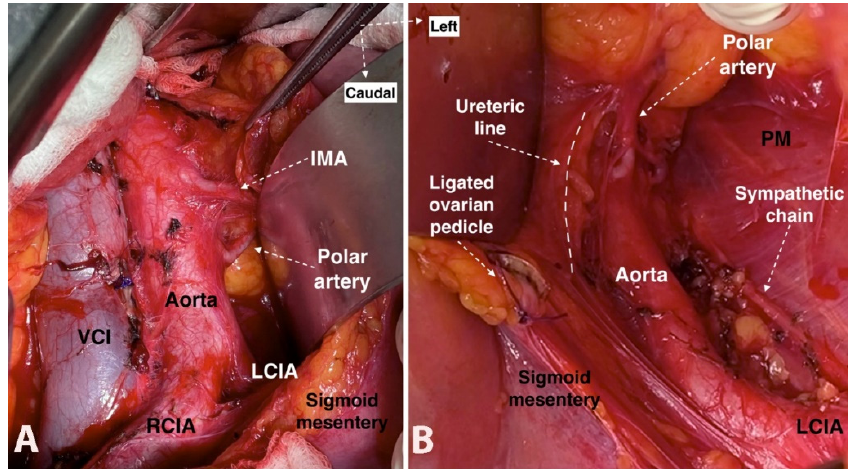
Figure 10. Additional left aortic lower polar renal artery arising from the lateral aspect of the abdominal aorta (embalmed cadaver). The artery originates from the abdominal aorta just below the origin of the inferior mesenteric artery. AA—abdominal aorta, IVC—inferior vena cava, RCIA—right common iliac artery, LCIA—left common iliac artery, LCIV—left common iliac vein, LRV—left renal vein, LRA—left renal artery, ARA—additional left aortic lower polar renal artery, Ur—ureter,